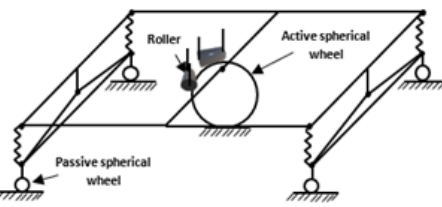
Figure 1. The main feature of the model is the omnidirectional plat- form displacement. This characteristic allows us to generate a kine- matic and dynamic model (Muir and Neuman, 1987).